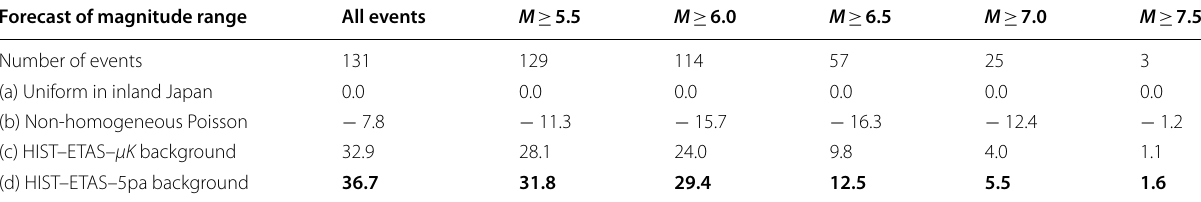
Table 5 Spatial log-likelihood score of long-term “reverse prediction” of historical disaster earthquakes for 1500–1884 that are at a